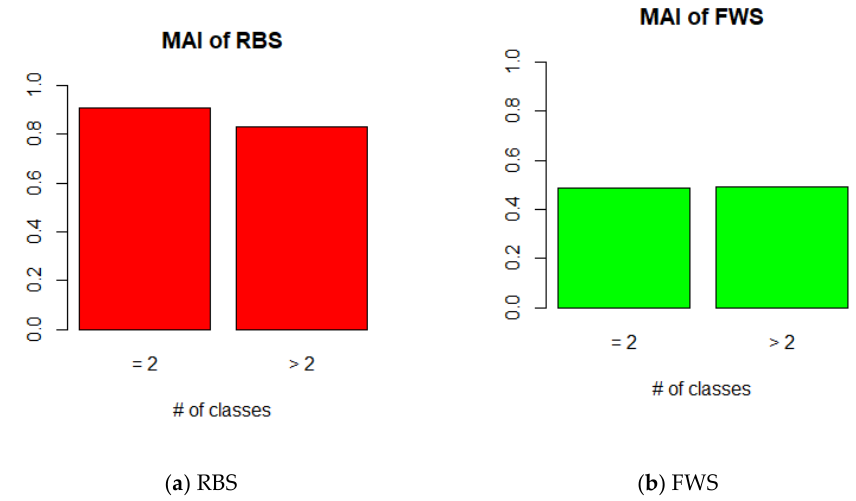
Figure 12. MAI of FWS according to number of class (K=3, bin width=hybrid).